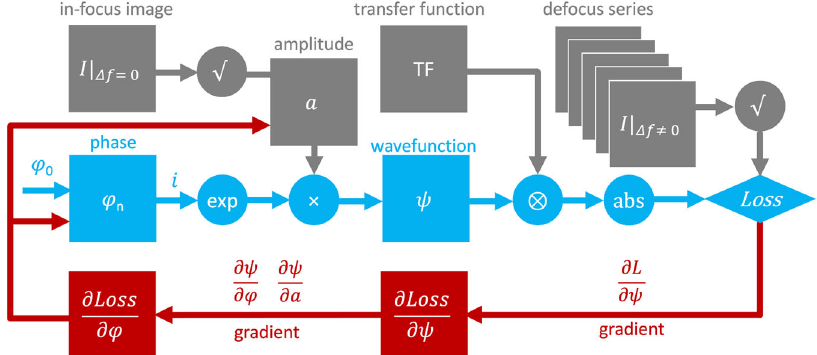
Fig. 1 Flow chart of phase retrieval in LTEM through differentiable programming. The experimental data and instrument parameters are color coded in gray. The imaging process that carries the phase information is color coded in blue while the path for back-propagation is color coded in